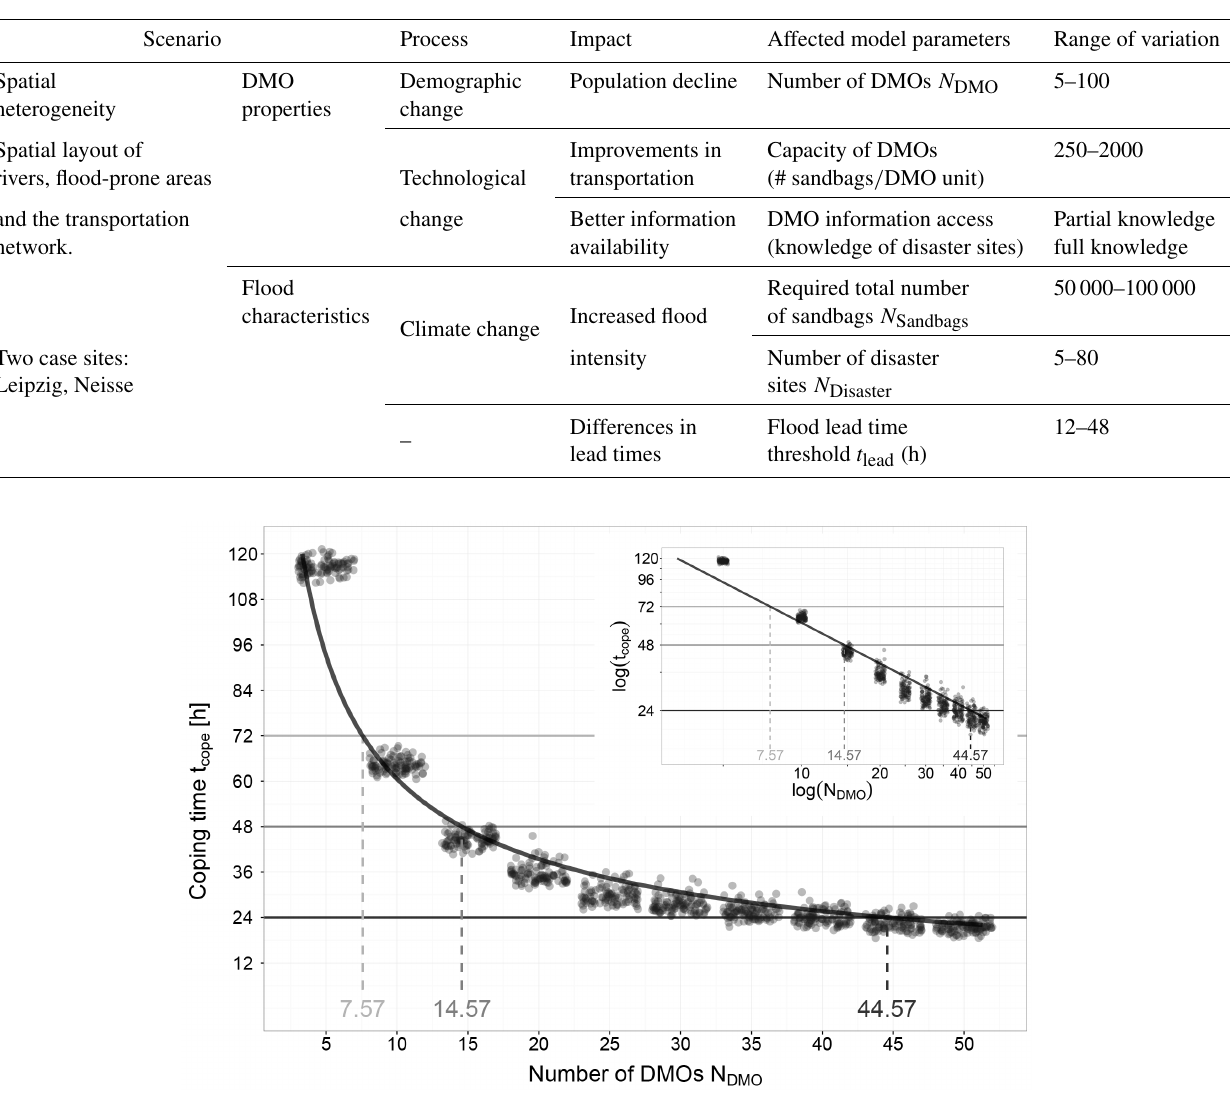
Figure 5. General qualitative relationship between coping time t cope and number of DMOs N DMO . Coping time decreases with increasing number of DMOs following a power law relationship (as depicted in the smaller inset plot, showing the same data on a log–log scale). Dots represent results of single simulations, where overlapping dots result in darker colors. Black curve shows the fitted power law and the intersection with the 24, 48 and 72h threshold yields the minimum number of DMOs necessary to achieve that coping time. Results correspond to a flood setting of 40 disaster sites and a total demand of 50000